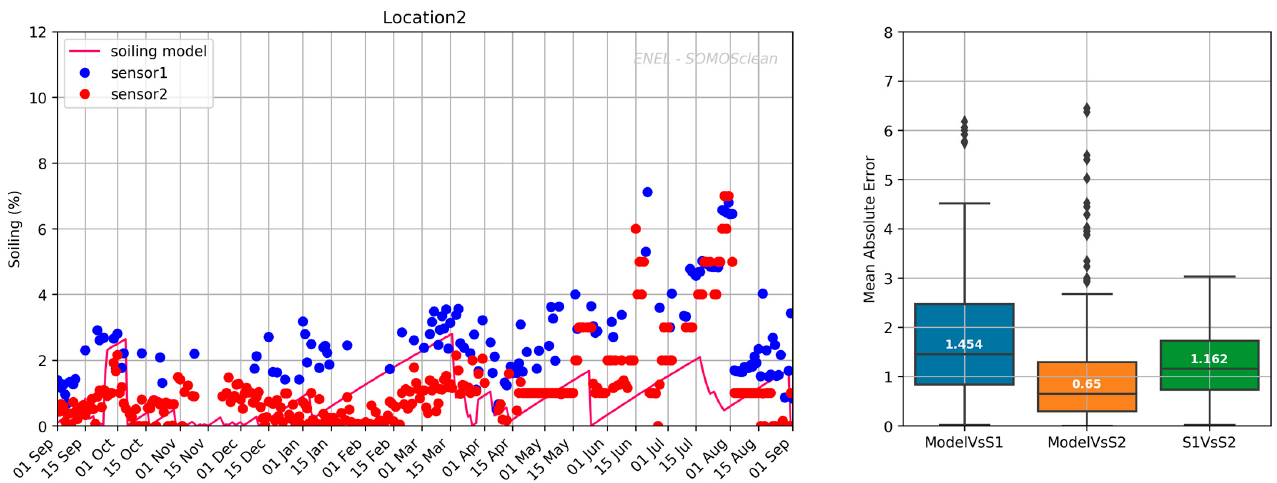
Figure A2. Soiling data from the power plant at location 2.